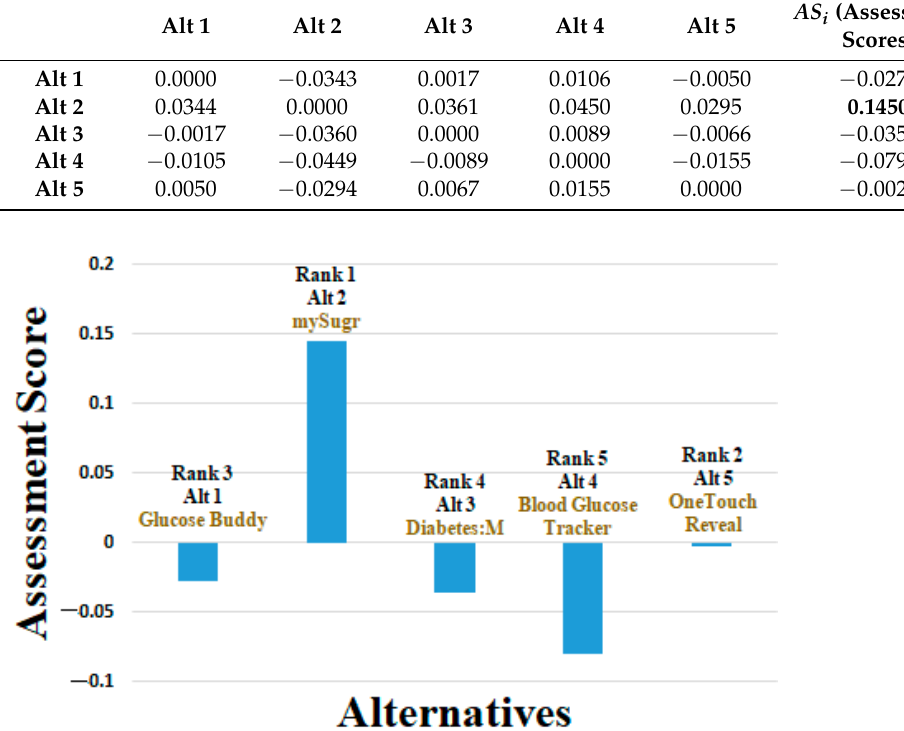
Figure 5. Rank obtained by CODAS based on assessment score.